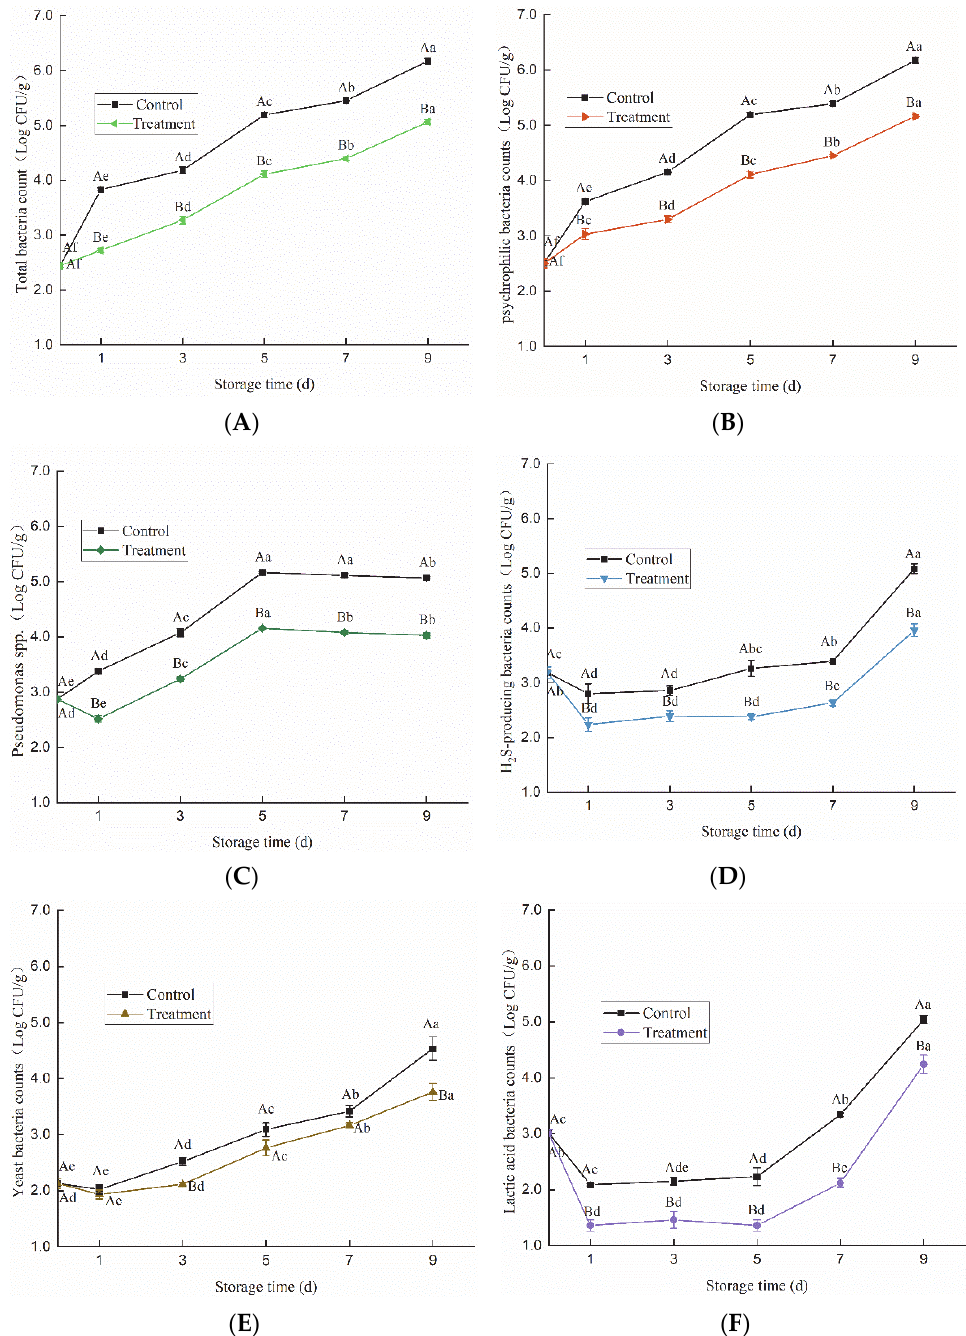
Figure 2. Changes in the number of microorganisms of Trachinotus ovatus during refrigerator storage (total bacteria count ( A ), psychrophilic bacteria ( B ), Pseudomonas spp. ( C ), H 2 S-producing bacteria ( D ), yeast ( E ), and lactic acid bacteria ( F )).